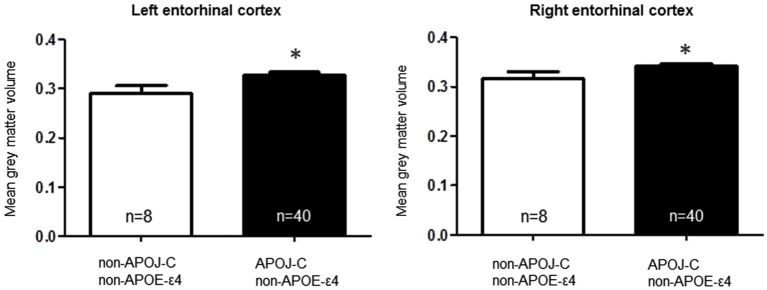
Apolipoprotein J-C AD risk genotype is associated with greater bilateral entorhinal cortex volume, in noncarriers of
APOE-ε4. A two-tailed t-test demonstrates that when non-APOE-ε4 carriers are grouped based on APOJ status, APOJ-C carriers have higher left entorhinal cortex volume, t(46) = 2.05, p = 0.0458, and right entorhinal cortex volume, t(46) = 2.03, p =0.0485. (*p < 0.05, n = 40 APOJ-C carriers, n = 8 non-APOJ-C carriers).